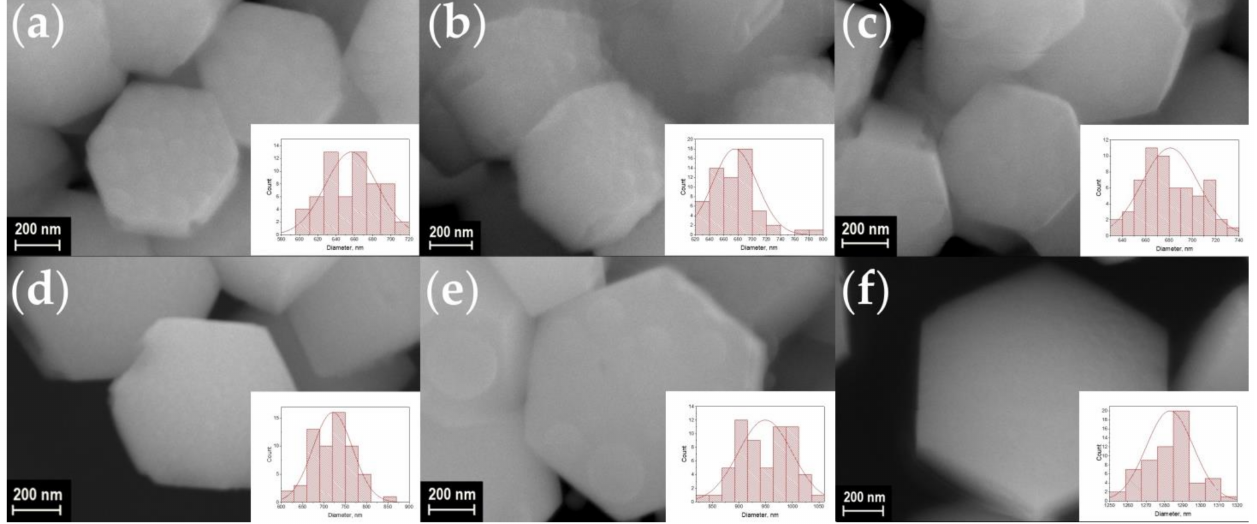
Figure 6. SEM images of the samples NaY 0.98 − x Sm 0.02 Lu x F 4 ( a – f ): x = 2, 5, 10, 20, 40, and 60 at.% Lu, respectively. Particle size distribution of the samples is shown in the insets. The average diameter of particles is equal to about, 657 ± 29, 676 ± 31, 681 ± 24, 721 ± 46, 949 ± 50, and 1283 ± 13 nm for the Lu 3+ concentration of 2, 5, 10, 20, 40, and 60 at.%, respectively.